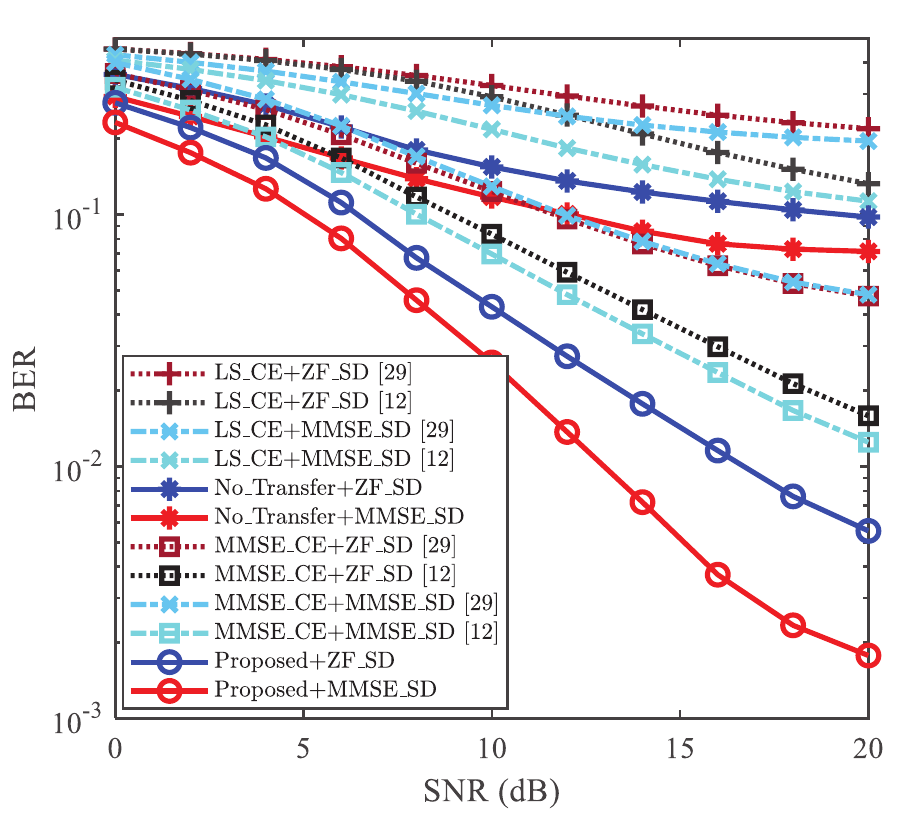
Fig 4. BER vs. SNR, where N = 256, L = 8, P = 8, and ρ = 0.2. https://doi.org/10.1371/journal.pone.0268952.g004 This embodies that ReCNN can still extract certain CSI features in the case where the environ- ment is changed. From Fig 3 and Table 2, the NMSE of “Proposed” reaches the minimum in all SNR region, even compared with the “MMSE_CE [12]”. For example, the NMSE of “Pro- posed” is 4.9 × 10 − 3 for the case of SNR = 20dB, while the NMSE of “MMSE_CE [12]” is 1 × 10 − 1 . This reflects that the “Proposed” obtains higher CE accuracy than “MMSE_CE [12]”, and thus it can work well in the varied environment. Thus the Proposed scheme possesses its effectiveness to improve the NMSE of CE. Since the PS c is superimposed on the modulated data symbol s , it needs to be verified whether the superimposed interference (from the ST) degrades the detection performance of data symbols. In this paper, the BER is used to measure the detection performance and is Table 2. The NMSE of each